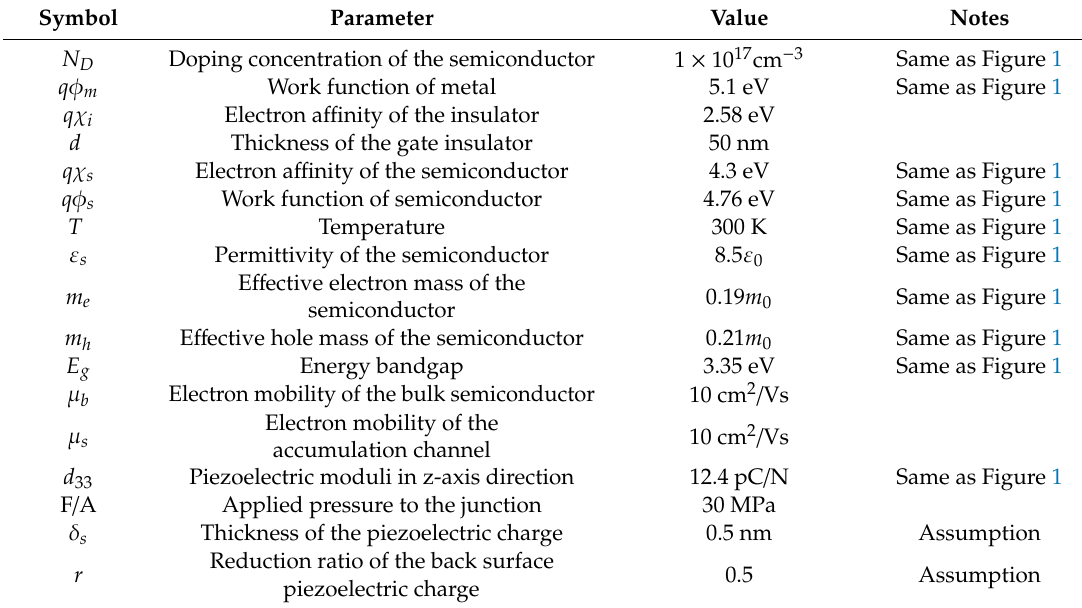
Table A9. List of parameters used in the plots in Figure